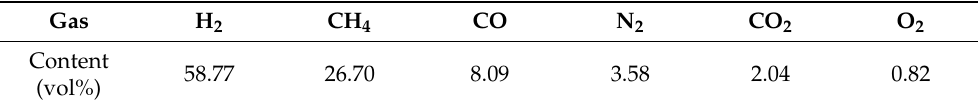
Figure 1. Schematic of equipment for thiophene removal. Table 1. Composition of simulated